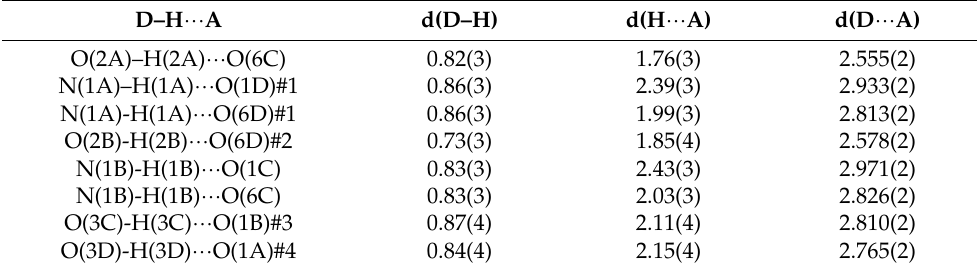
Table 3. Hydrogen bonds for the N,N-dimethylglycine–chloranilic acid co-crystal (Å and ◦ ).